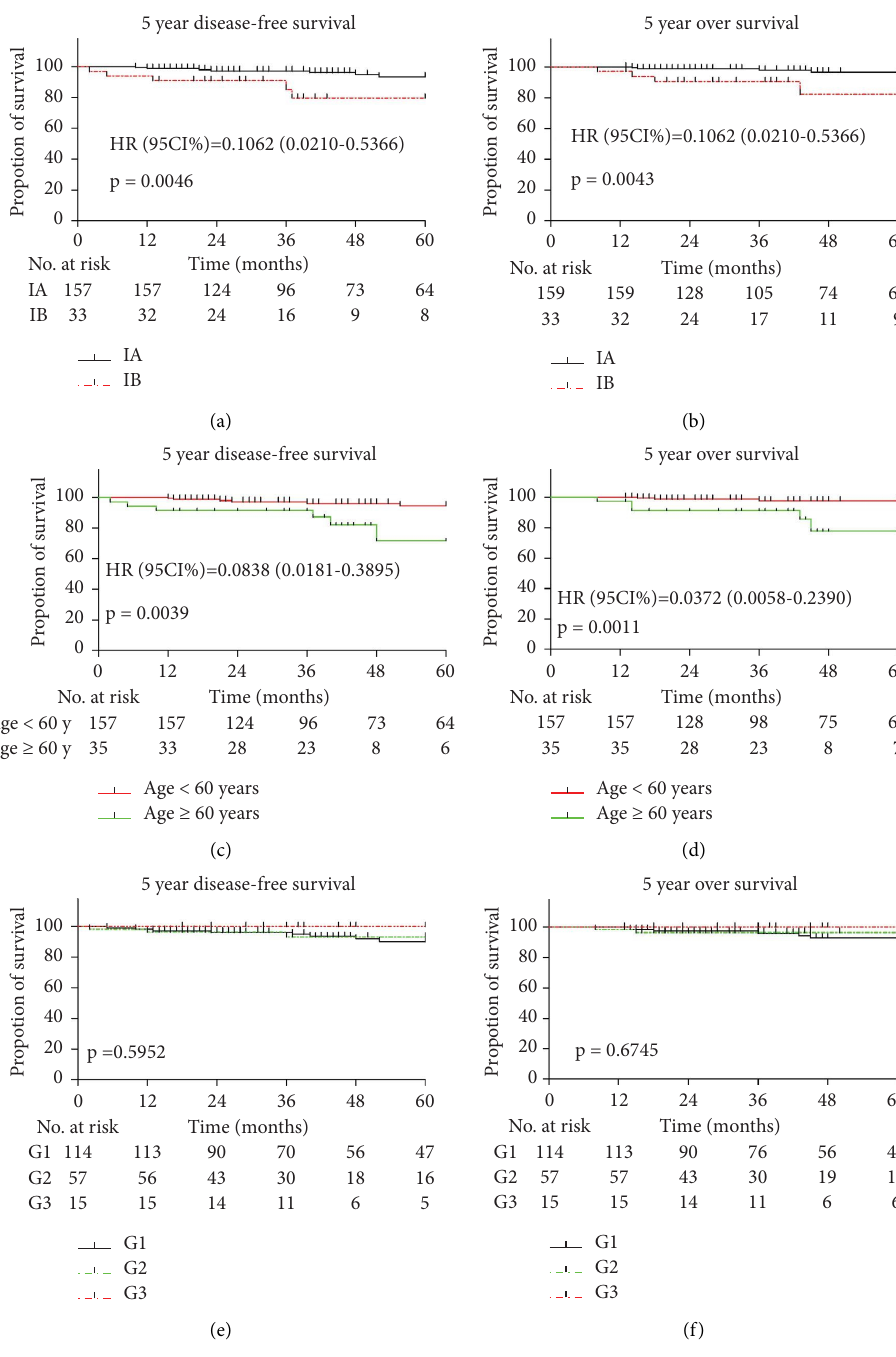
Figure 3: Estimates of the 5-year disease-free survival and 5-year overall survival in all patients by FIGO stage, age and degree of dif- ferentiation. Kaplan-Meier survival curves for the 5-year disease-free survival and 5-year overall survival by FIGO stage (a, b) and age (c, d). [(a), HR (95% CI): 0.1062 (0.0210–0.5366), P � 0 . 0046; (b) HR (95% CI): 0.0566 (0.078–0.4047), P � 0 . 0043; (c) HR (95% CI): 0.0838 (0.0181–0.3895), P � 0 . 0039; and (d) HR (95% CI): 0.0372 (0.0058–0.2390), P � 0 . 0011]. Panels (e) and (f) show disease-free survival